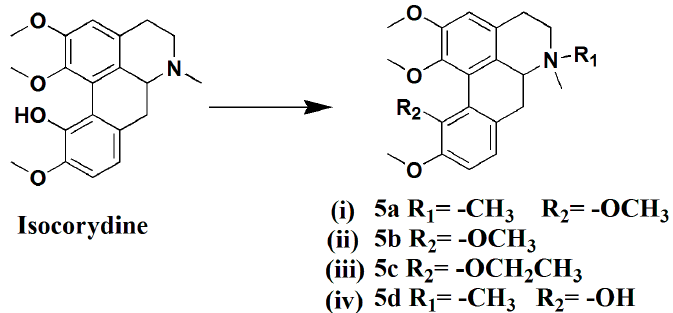
Scheme 4. Synthesis of isocorydine derivatives 5a , 5b , 5c , and 5d . Reagents and conditions: ( i )